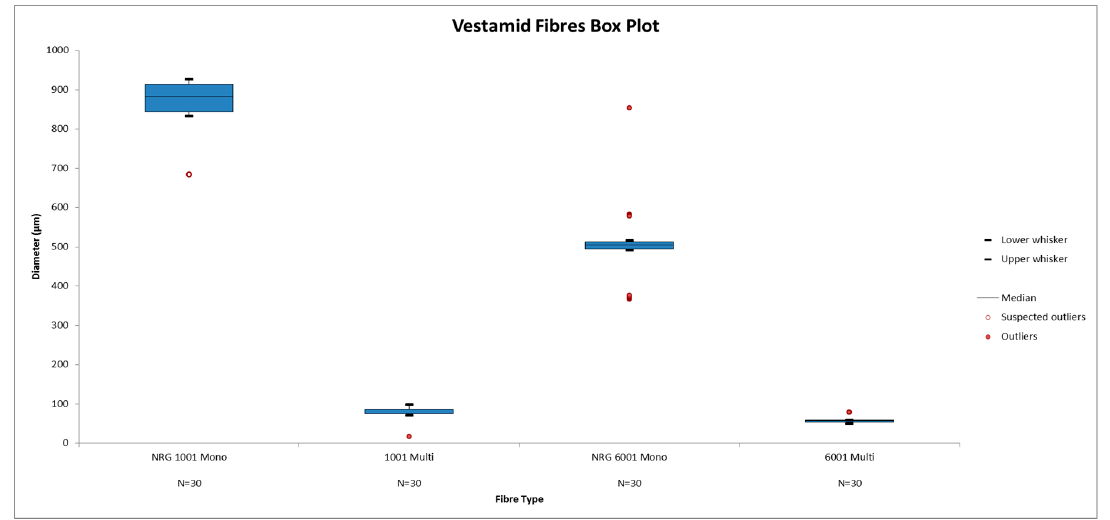
Figure 7. Vestamid fibres diameter box plot.